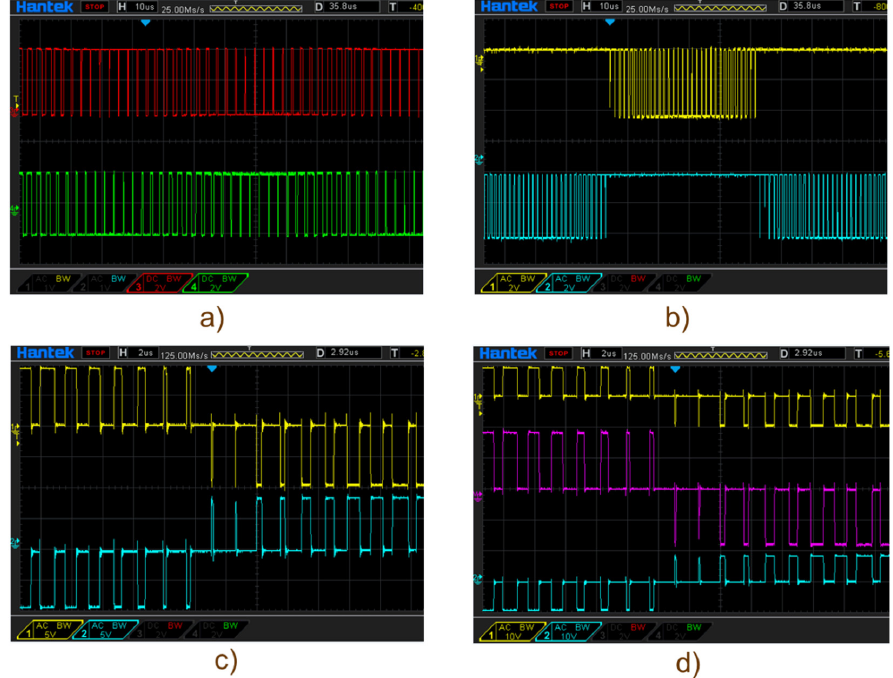
Figure 13. Oscillograms of the control signals generated by the hybrid 9 bit LBDD PWM modulator in Figure 4b with extended architecture with f c 1 = 328 kHz and f m = 30 kHz: ( a ) PWM L and PWM R signals; ( b ) S 1 and S 2 signals; ( c ) output voltages in DM and CM for amplifier from Figure 5 ( V DD = 18 V; R L = 8 Ω ; L = 30